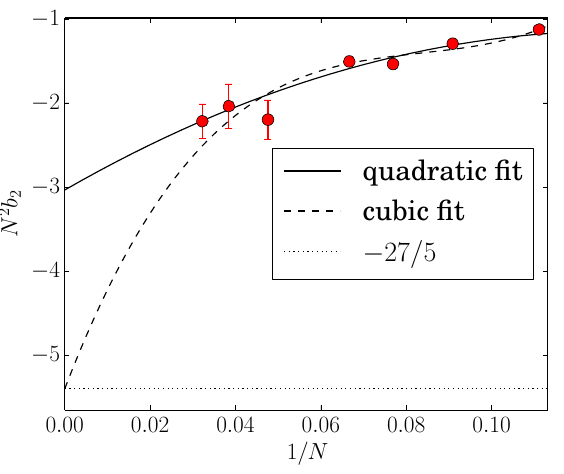
Figure 8 . Large- N behavior of N 2 b 2 . A quadratic and a cubic fit are also shown and in the cubic case the constant term was fixed to the theoretical